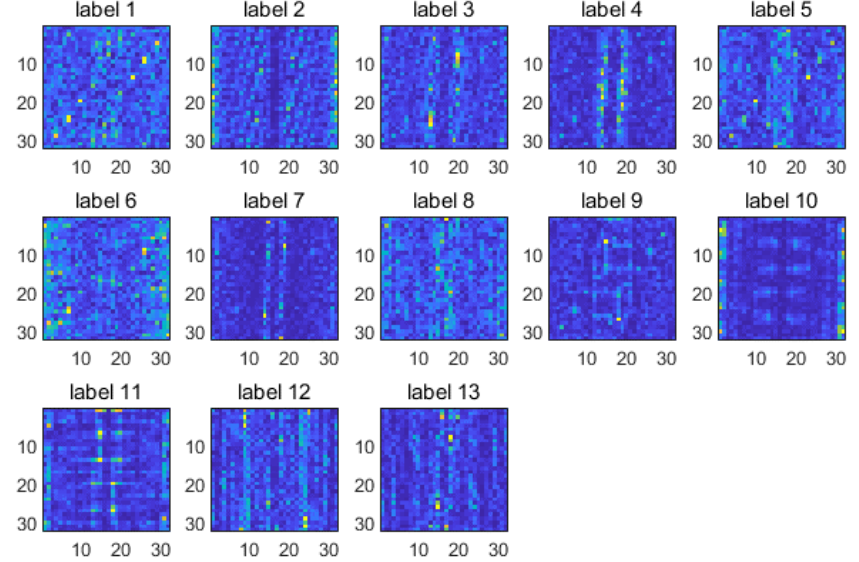
Figure 9. Visualization of the data after FFT.